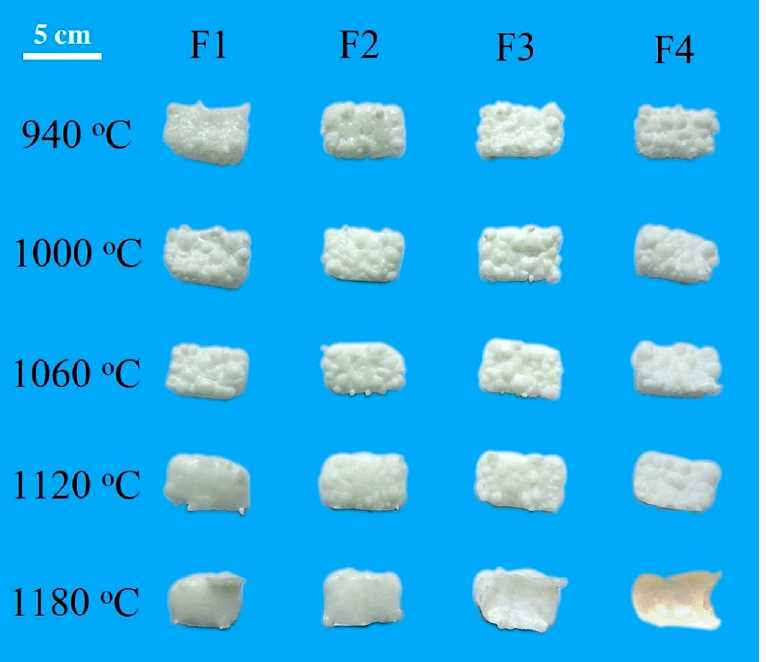
Figure 8. The influence of CaF 2 addition on the appearance of the glass-ceramic samples at different temperatures.